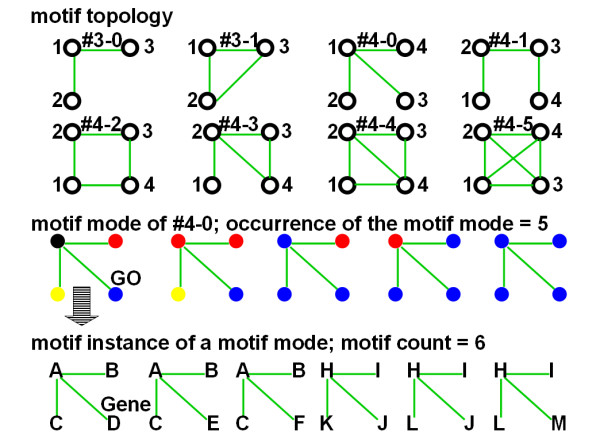
Motif topology, motif mode, motif instances and motif count. Eight motif topologies of three-node and four-node motifs are labeled as indicated #3–0, #3–1, #4–0, #4–1, #4–2, #4–3, #4–4 and #4–5. Motif modes of a motif topology (e.g. #4–0) are shown, each colored node indicating GO terms. Motif instances are examples of motifs derived from one of the motif modes, with each node given a gene name.